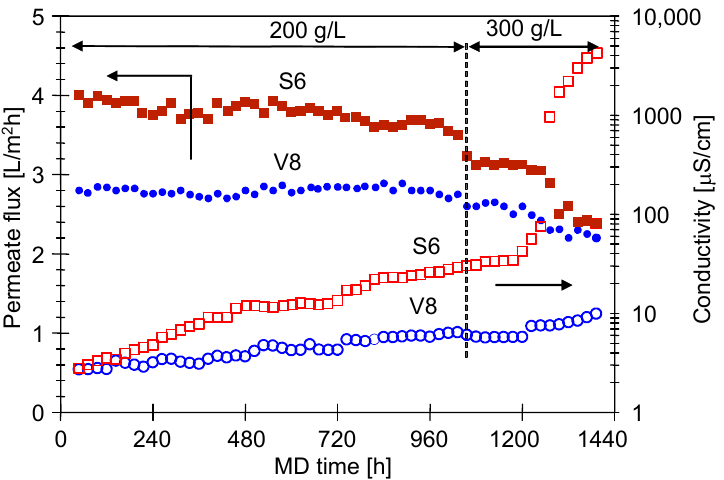
Figure 10. Changes in the permeate flux and distillate conductivity. Feed: NaCl solution (200 or 300 g/L) + oil (130–153 mg/L) + SDS (2 mg/L). Modules: SMD ‐ S6 ‐ 1 and SMD ‐ V8 ‐ 1.